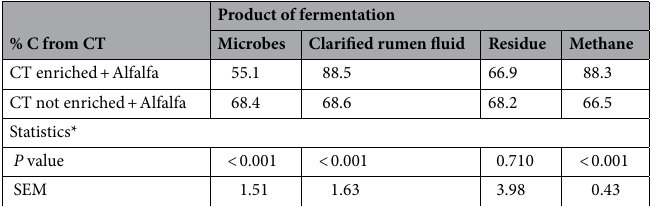
Product of fermentation % C from CT Microbes Clarified rumen fluid Residue Methane CT enriched +